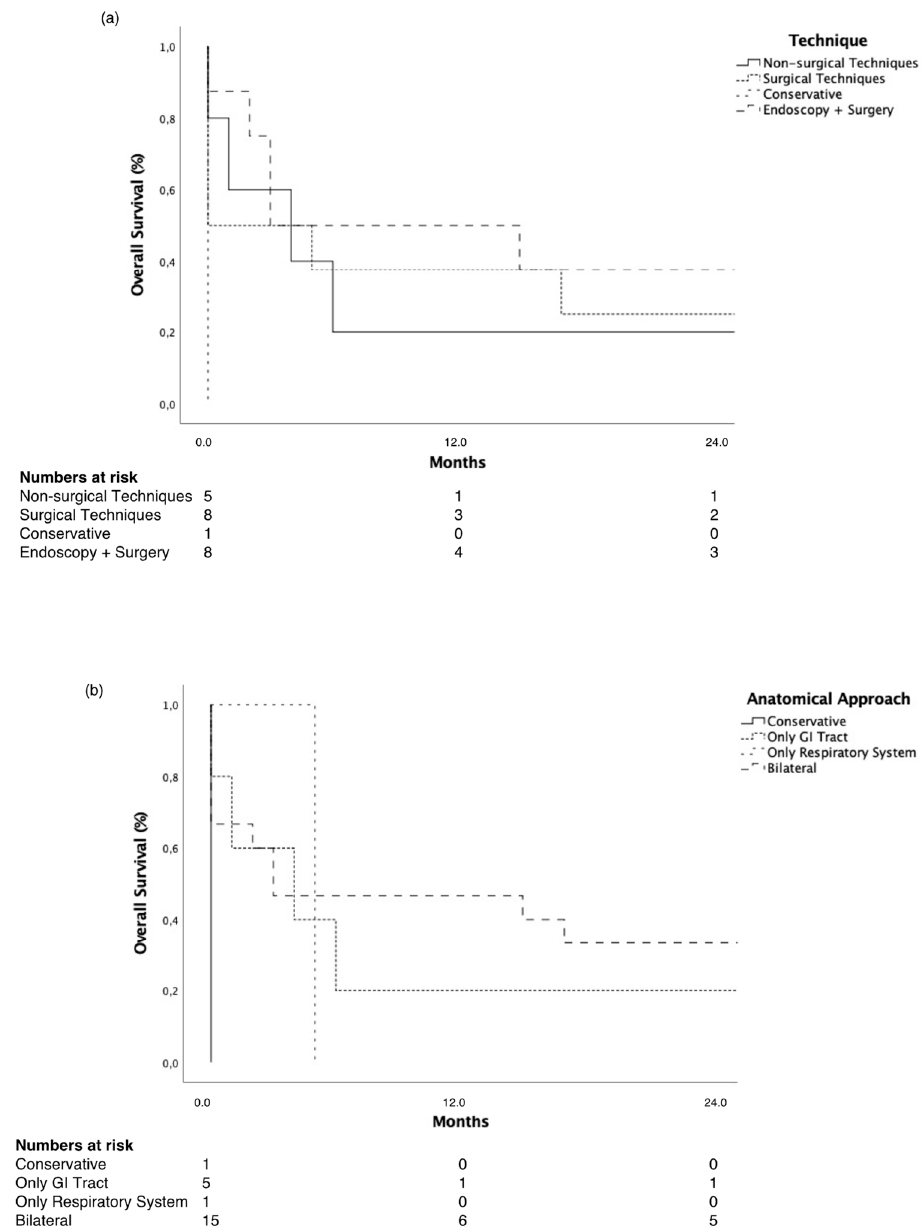
Figure 2. Overall survival by ( a ) interventional technique and ( b ) anatomical approach in S-RDF. ( a ) All interventional techniques were associated with significantly longer overall survival compared to best supportive care (non-surgical techniques p = 0.03, surgical techniques p = 0.005, combined endoscopic and surgical techniques p = 0.005). ( b ) Bilateral ( p < 0.001) and only GI tract approaches ( p = 0.03) were significantly associated with improved survival compared to best supportive care.